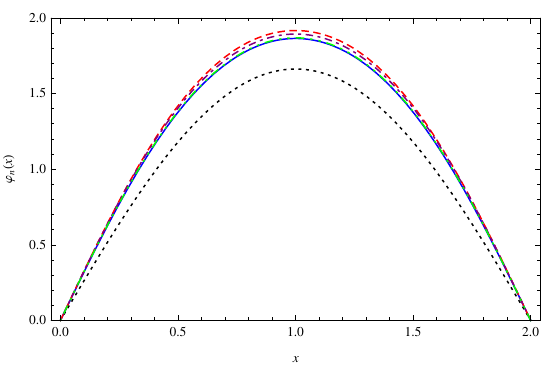
Figure 7: Curves of u * ( x ) (solid line) and the matched n th-stage approximations φ n ( x ) for n = 2 (dot line), n = 3 (dashed line), n = 4 (dot-side line), and n = 5 (dot-dot-side line).